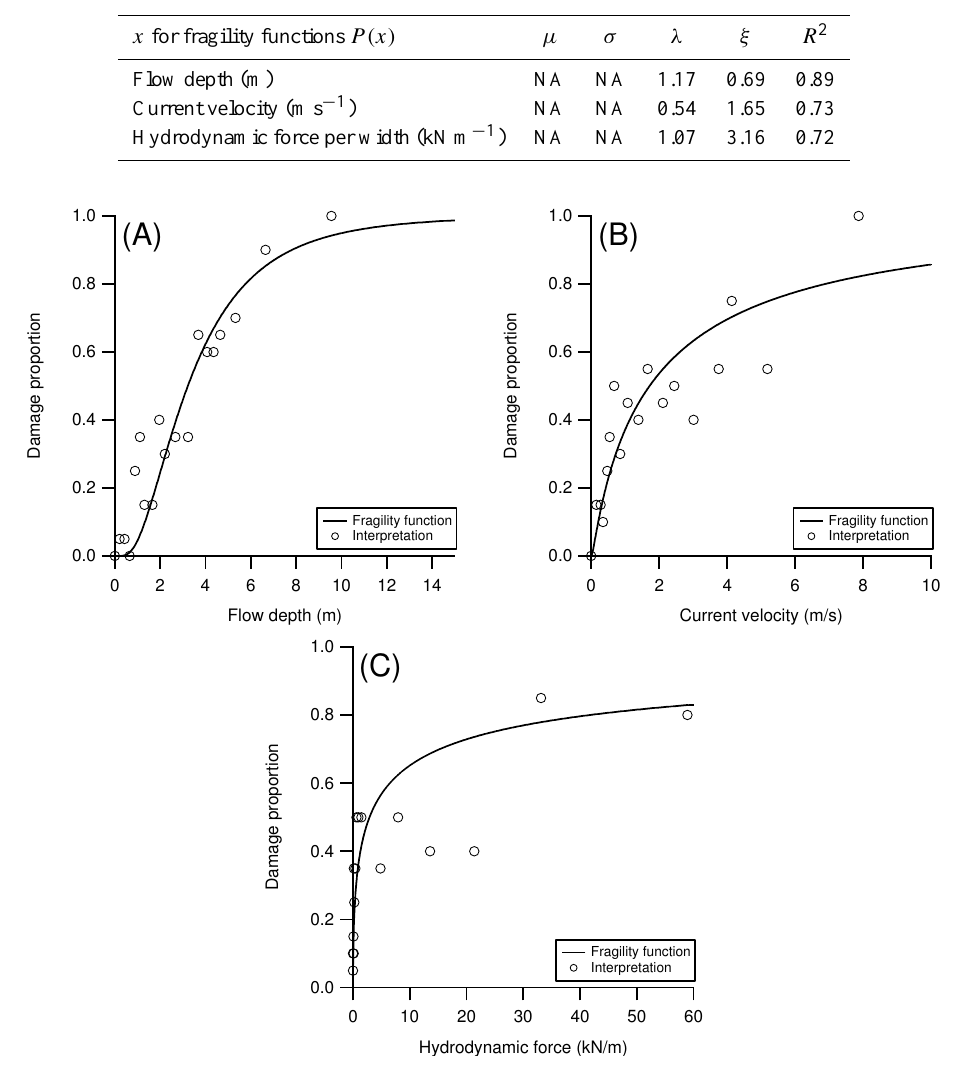
Figure 8. Fragility functions of (a) maximum flow depth, (b) maximum current velocity, and (c) maximum hydrodynamic force. Fig. 8. Fragility functions of (A) maximum flow depth, (B) maximum current velocity, and (C) maximum hydrodynamic force. fragility functions were strongly influenced by the residential buildings made of woods or woods with